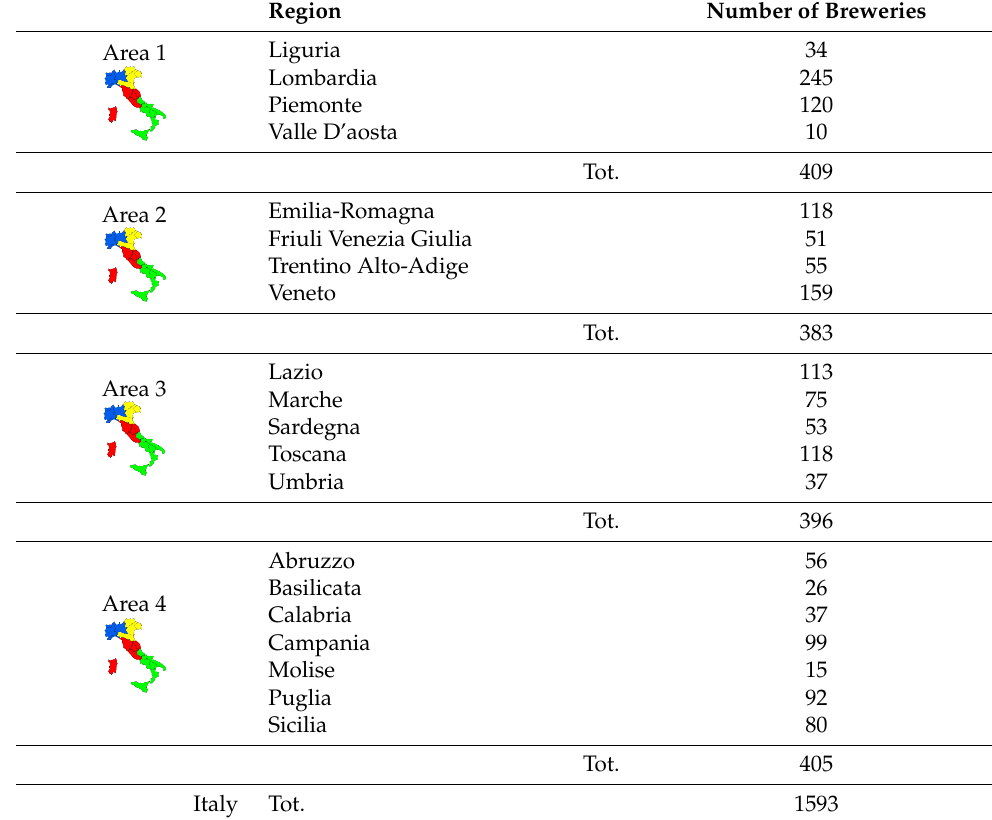
Table 1. Distribution of breweries in Italy based on region and Nielsen area.